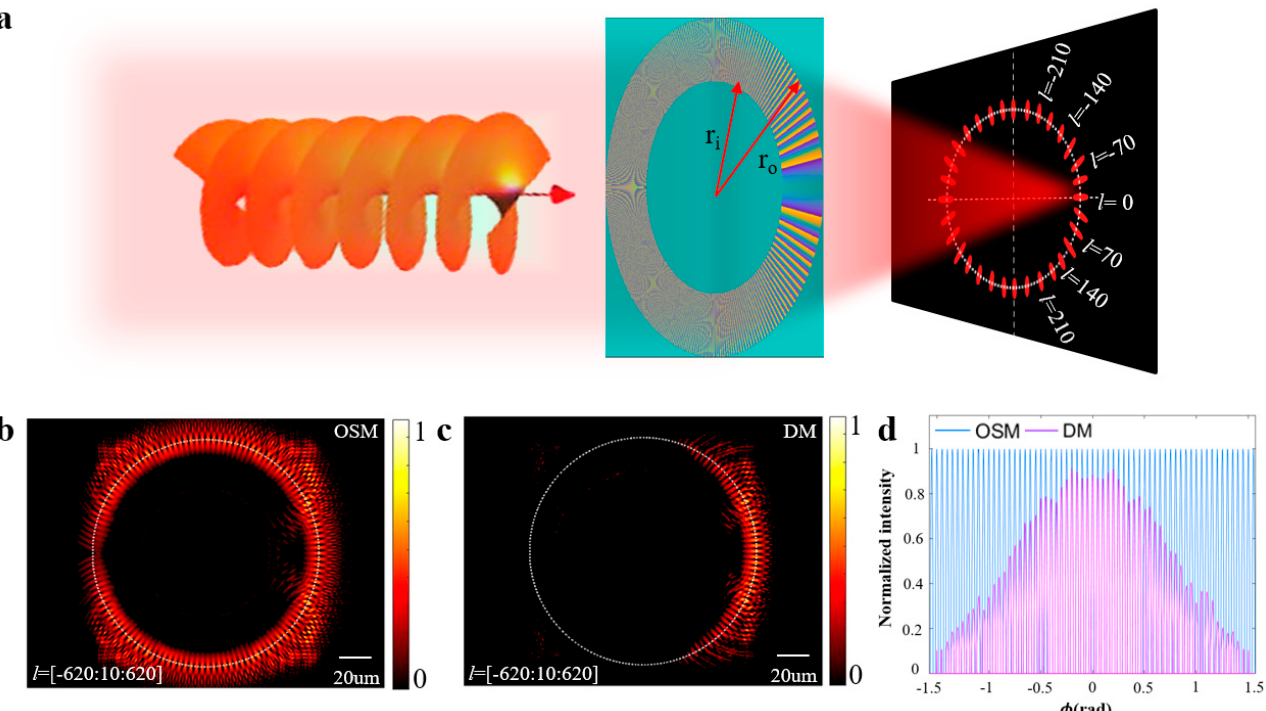
Figure 1. Comparison of the OSM and DM for detection and separation of the different OAMs’ modes at 633 nm. ( a ). PMT diagram of LCP vortex light passing through a phase plate when l 0 = 200, r i = 50 µ m, and r o = 80 µ m. ( b ). OSM ( l 0 = 200) simulation results of the OAMs at l = − 620 to l = 620, ∆ l = 10. ( c ). Simulation results of DM ( l 0 = 200) with period p = 600 nm and under the same conditions as ( b ). According to the square result, the detection fails when φ l exceeds ± 1.36 rad. ( d ). Intensity curves along the white dotted circle line in ( b , c